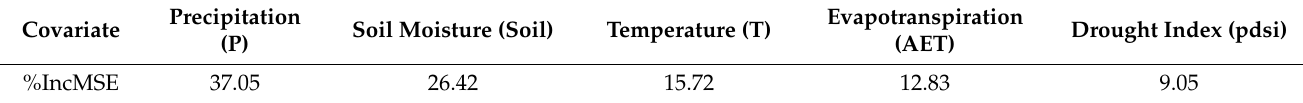
Table 1. The variance importance of climate factors.